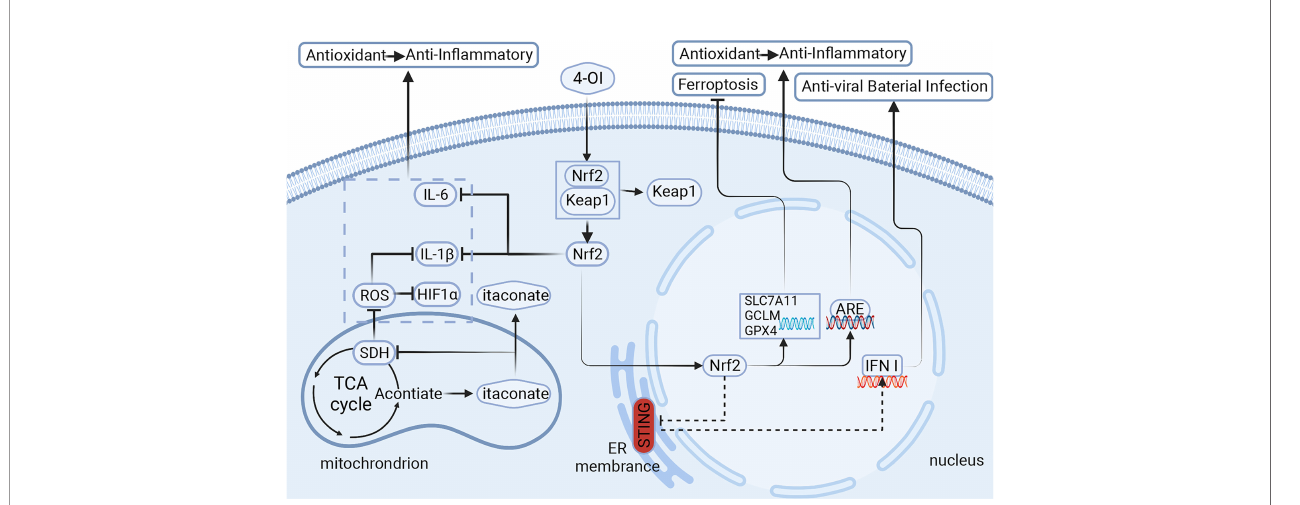
FIGURE 1 | Itaconic is derived from TCA cycle metabolites and is highly expressed in macrophages. It regulates the metabolites in macrophages through different signaling pathways, which affect the polarization of macrophages and the release of cytokines, and then plays a role in vivo . Signaling pathways of itaconate and its derivatives:1.Itaconate activates Nrf2 for anti-in fl ammatory and antioxidant. 2.Itaconate negatively regulates STING for anti-viral and bacterial infection. 3.Itaconate inhibits ferroptosis in macrophages. 4-OI,4-octyl itaconate;Nrf2,nuclear factor erythroid related factor 2; Keap1,Kelch-like ECH-associated protein 1; ARE, antioxidant response element; STING, stimulator of interferon genes; ROS, reactive oxygen species; SDH, succinate dehydrogenase; HIF1 a ,hypoxia inducible factor 1 subunit a ; GPX4/SLC7A11/GCLM, markers of ferroptosis.Created with